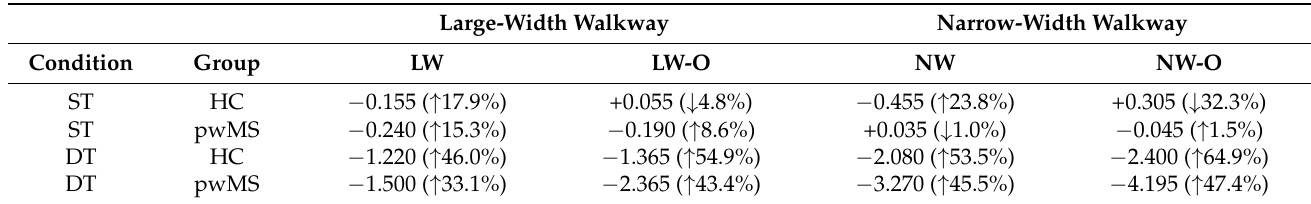
Table 3. Percent change in median A-MC following execution of walking trials.